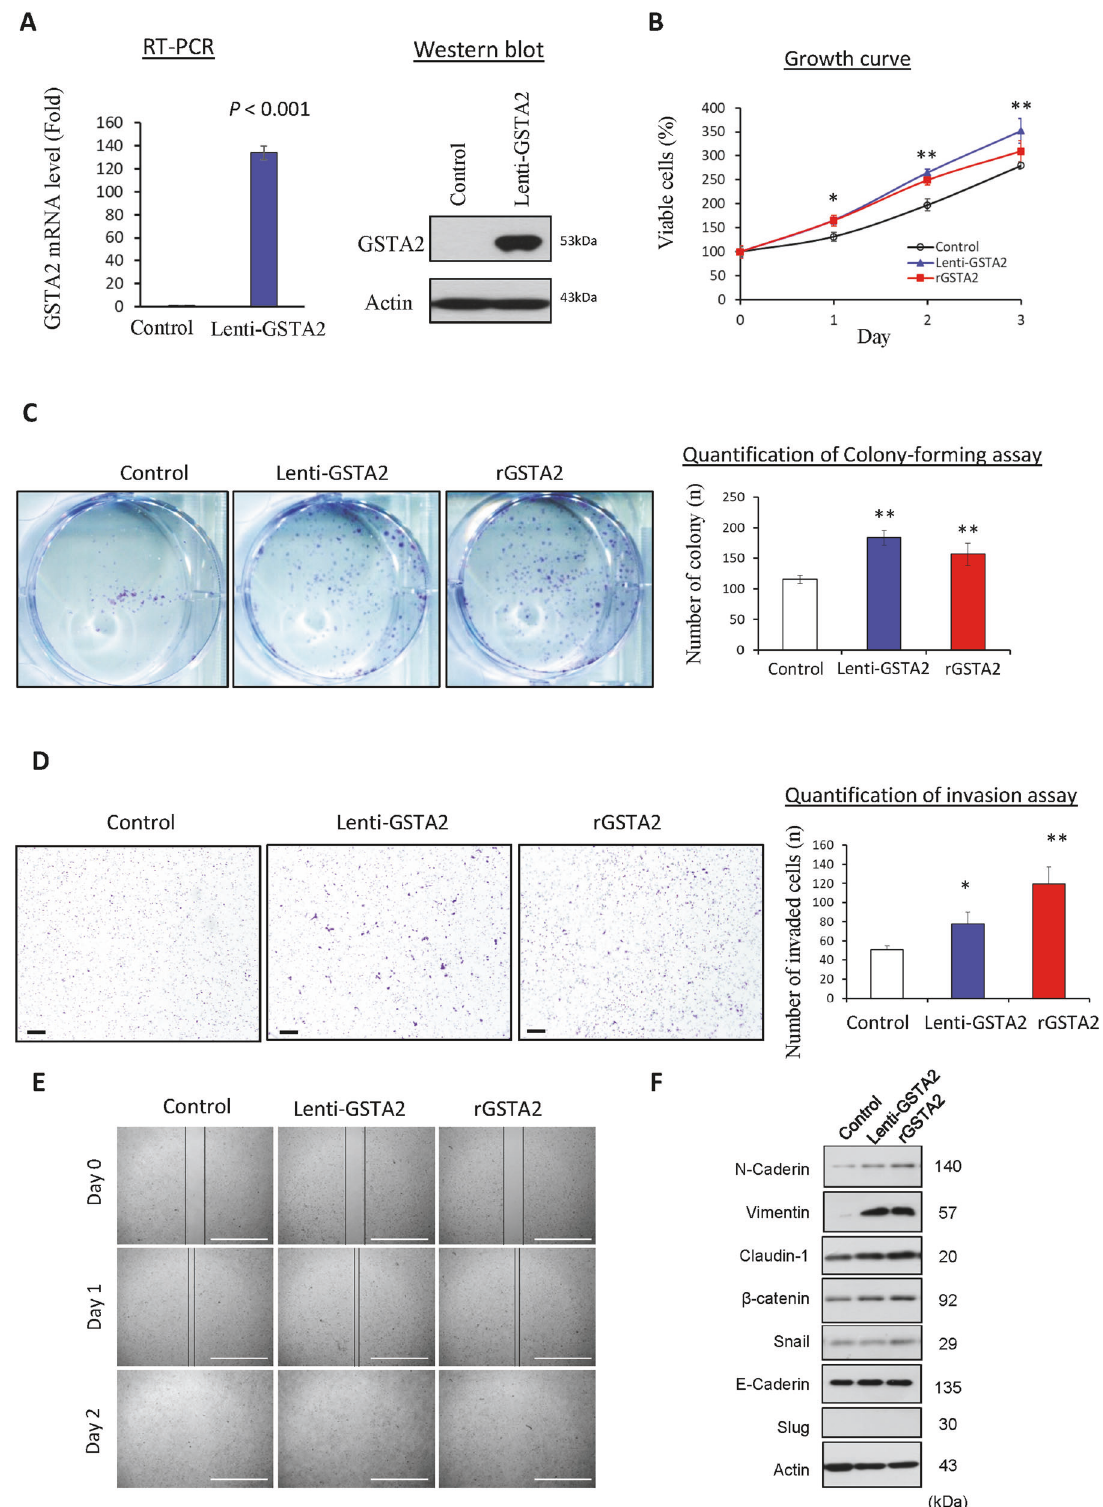
Fig. 5 Overexpression of GSTA2 promoted HCC growth and invasion. A The expression level of GSTA2 mRNA and protein in GSTA2- overexpressing HCC cells. B MTT assay of HCC cells after endogenously overexpressing GSTA2 by lentivirus (Lent-GSTA2) or administrating human recombinant GSTA2 protein (rGSTA2). C Colony-forming assay. D Matrigel invasion assay. Scale bar: 200 μ M. E Wound healing migration assay. Scale bar: 1000 μ M. F Western blot analysis of EMT-associated proteins.. Control, Hep3B-control cells; Lenti-GSTA2, Hep3B- LentiGSTA2 cells; rGSTA2, human recombinant GSTA2 protein. * P < 0.05; ** P < 0.01.